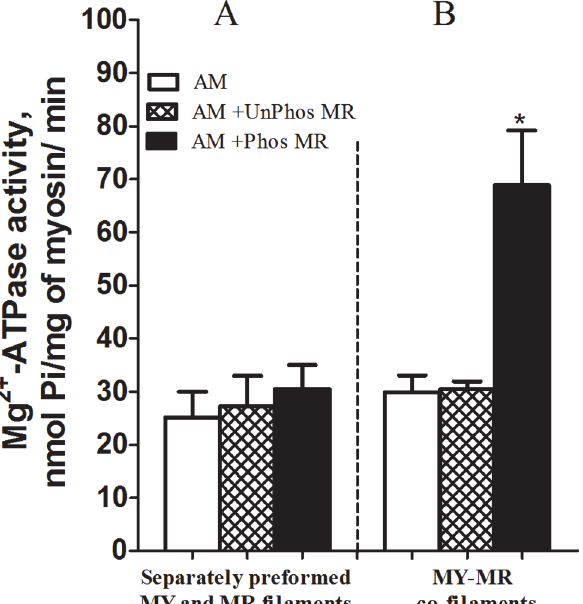
Fig 3. Influence of phosphorylation of myorod on the actin-activated Mg 2+ -ATPase activity of actomyosin reconstituted from separately preformed myosin and myorod filaments (A) and myosin and myorod co-filaments (B). Concentration used: mussel myosin, 0.1 mg/ml; rabbit F-actin, 0.2 mg/ml; UnPhosMR and PhosMR, 0.1 mg/ml. Each column represents the mean of results from three experiments ± SEM, one-way ANOVA, * :p <